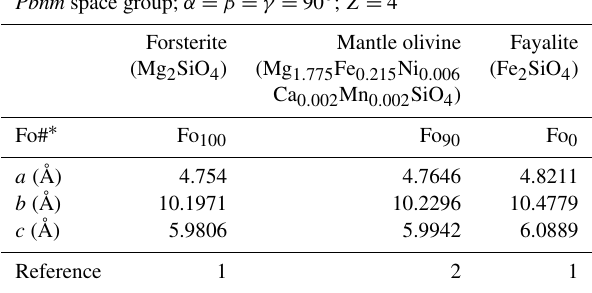
Table 1. Cell parameters of olivine end-members and a mantle olivine (representative peridotitic composition, from San Carlos, AZ). Error bars are typically around 0.05%.